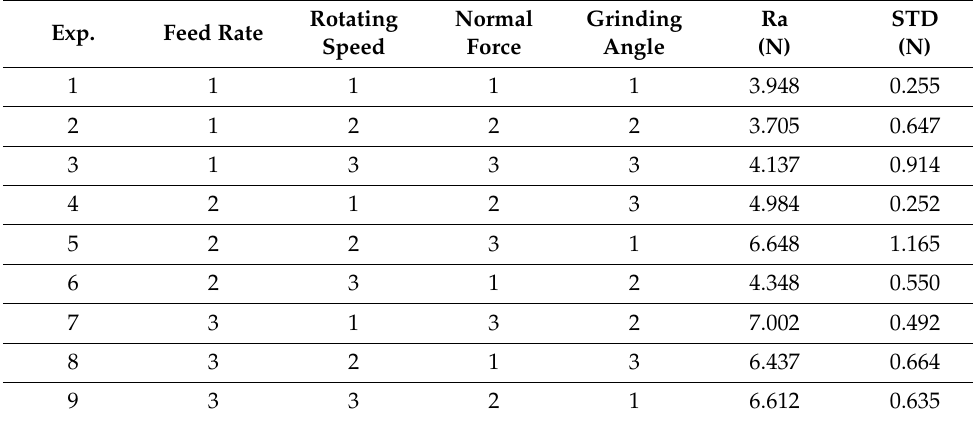
Table 2. L9 parameter combinations and grinding experimental results. Exp.